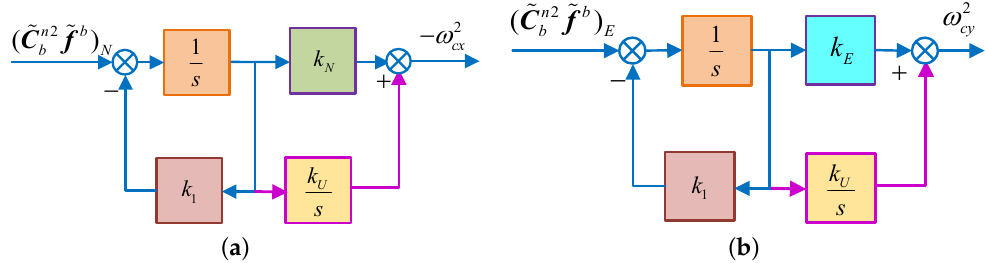
Figure 6. The schematic diagram of the control angular rate in System 2. ( a ) Schematic diagram of calculating ω 2 cx ; ( b ) schematic diagram of calculating ω 2 cy